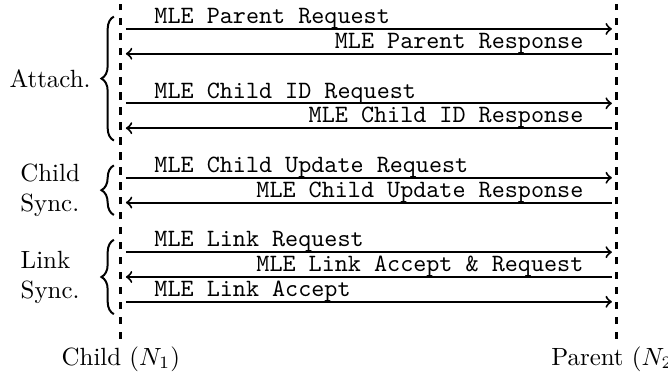
Figure 1: Establishing a communication link between two Thread